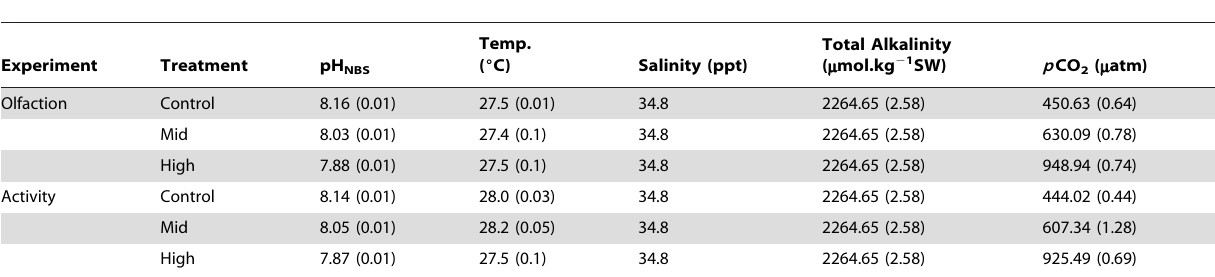
Table 1. Seawater parameters for the olfactory and behavioural experiments. Values are means ( 6 SE).